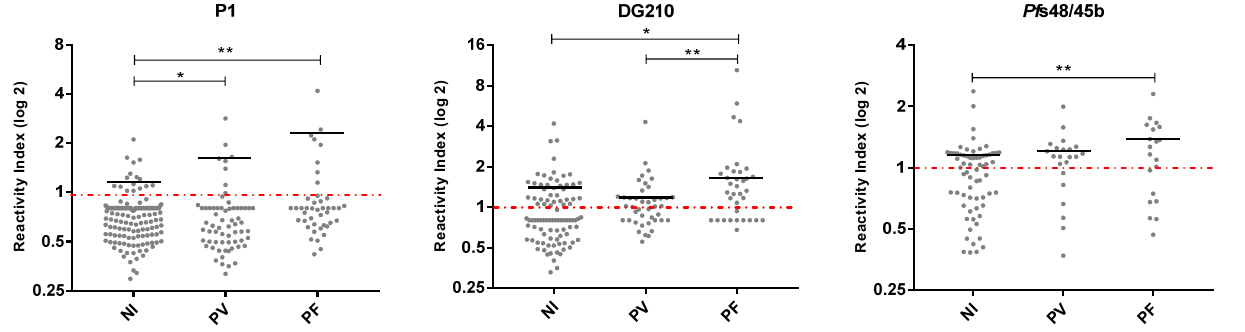
Figure 6. Levels of IgG antibodies (reactivity index) against P1, DG210, and Pfs48/45b epitopes in non-infected and infected by P. vivax and P. falciparum individuals. Reactivity indices are individual values. The dashed red line represents the positivity limit. Lines represent the median. NI: non-infected individuals; PV: P. vivax -infected individuals; PF: P. falciparum -infected individuals. P1: * p = 0.02 NI versus PV, ** p = 0.002 NI versus PF; DG210: * p = 0.01 NI versus PF, ** p = 0.001 PV versus PF; Pf s48/45b: ** p = 0.002 NI versus PF.